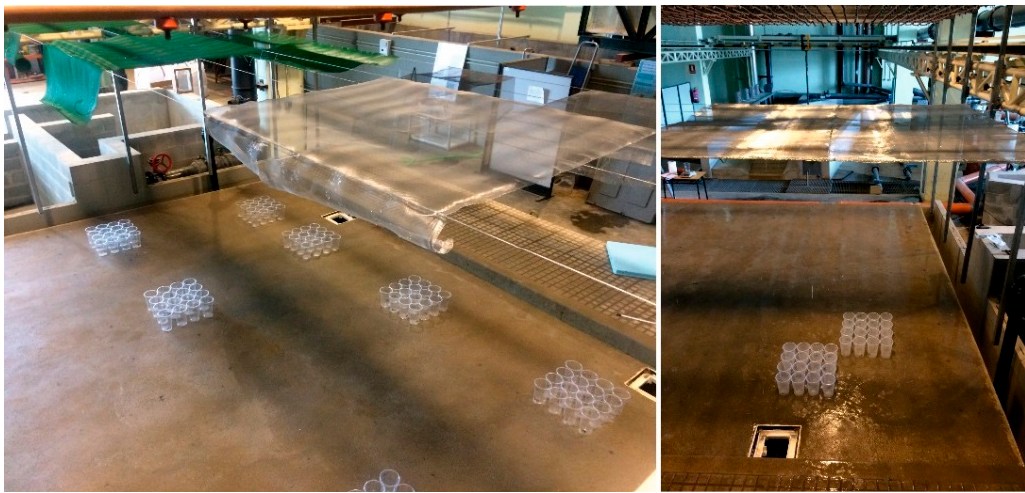
Figure 2. Vessels disposed over the model surface to measure rain intensity and uniformity for different mesh types and distances to drippers during calibration.